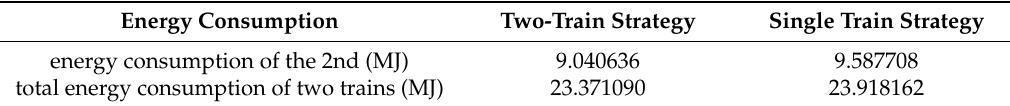
Table 3. Results between energy-saving strategies for the two-train system and single